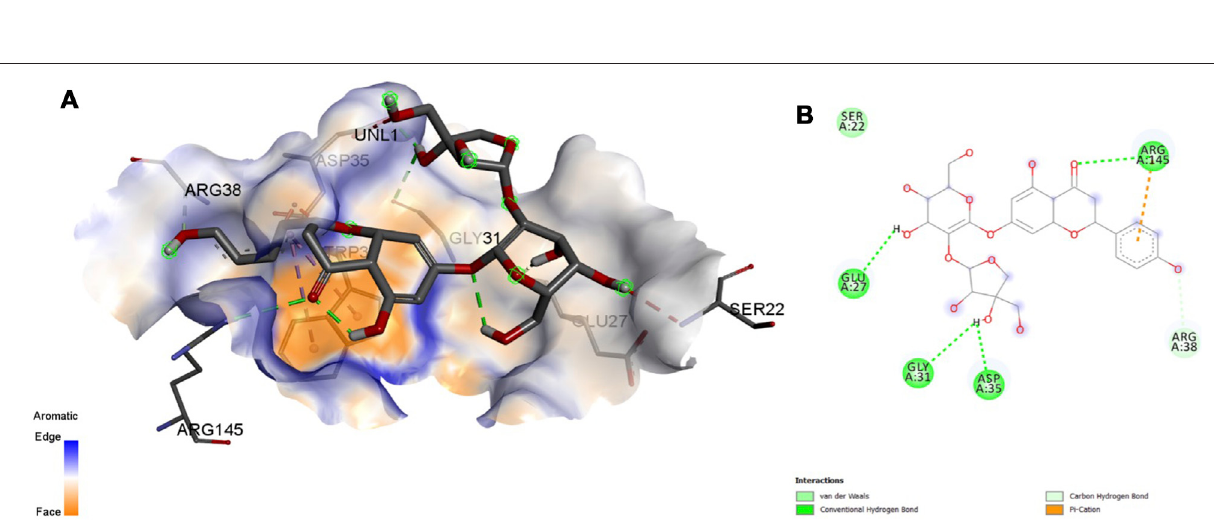
Frontiers in Chemistry |